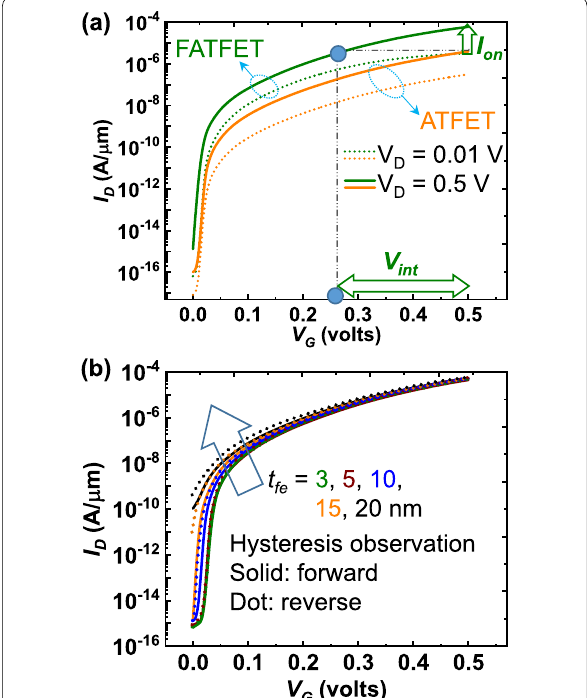
Fig. 5 a Collective comparison of the FATFET and ATFETs at different drain bias points ( V D = 0.01 and 0.5 V). A voltage gain of ≈ 0.2 V as V int is achieved in FATFET than the ATFET that amplifies I on . b Hysteresis observation in FATFET through scaled t fe during forward (solid) and reverse gate-bias sweep (dotted). Higher the t fe larger will be the